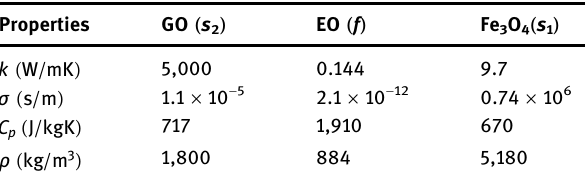
Table 1: Thermal properties of graphene oxide, EO and Fe 3 O 4